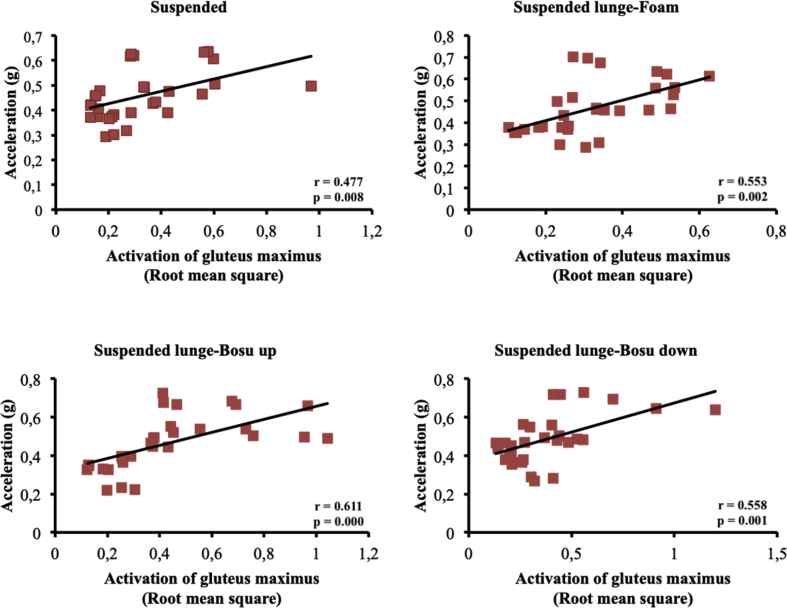
Correlation between gluteus maximus activation and acceleration values under suspended lunge conditions.